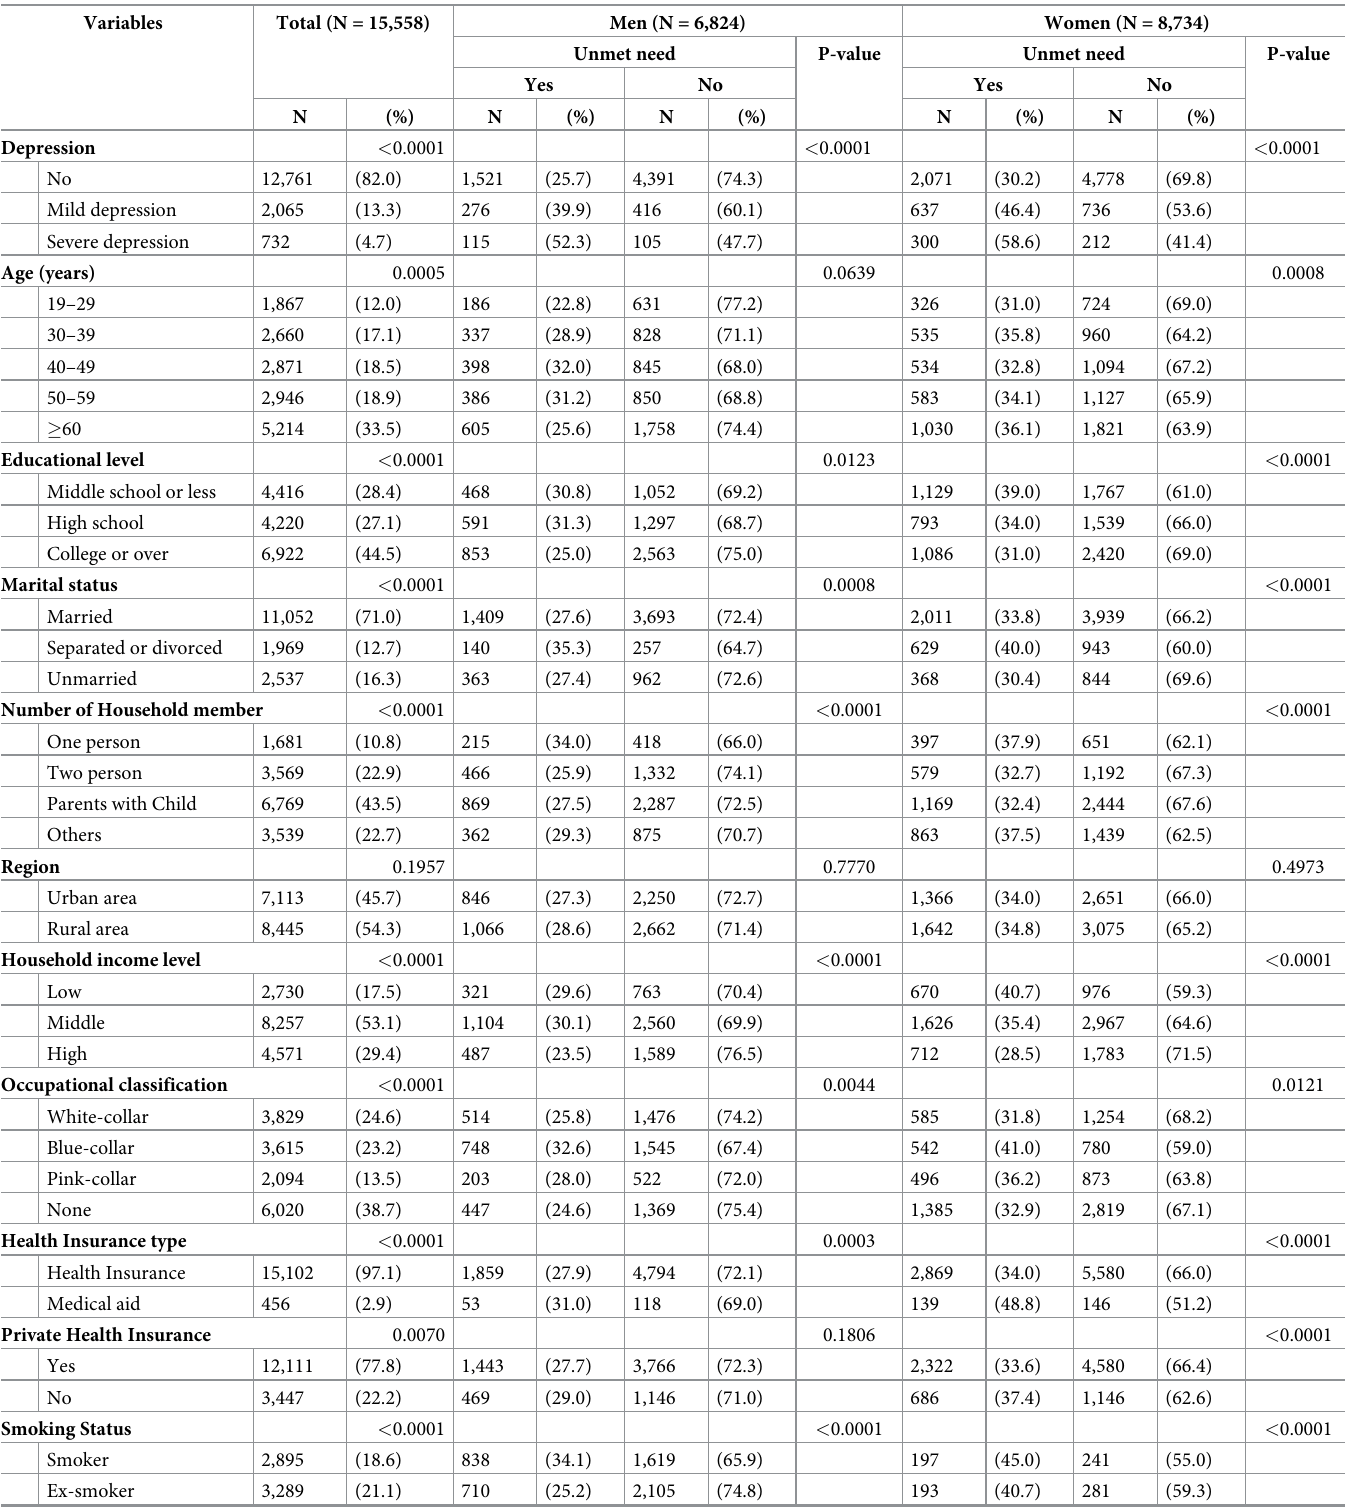
Table 1. General characteristics of the study